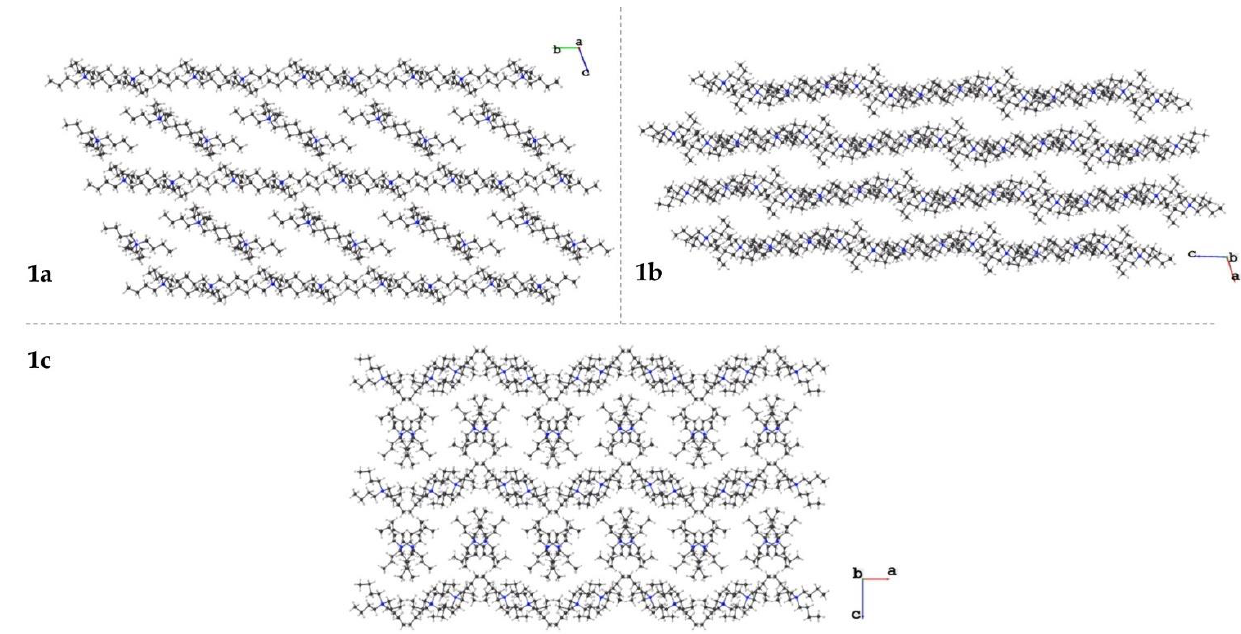
Figure 4. Crystal packing of the two crystallographically independent tetrabutylammonium cations for 1a (top left), 1b (top right), and 1c (bottom).